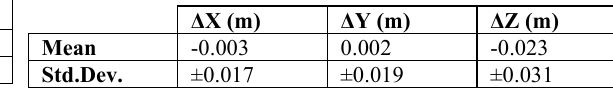
Table 3 RMSe on GCPs and CPs for standard processing of Table 5 Comparison between the coordinates of 16 CP dataset B. measured on the field and the coordinates of the same points estimated in the PPK processed with 1